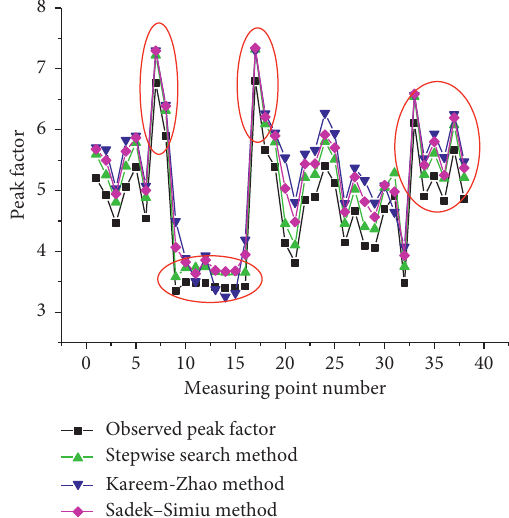
Figure 10: Comparison of peak factors at the 5 th measurement level with 90 ° wind direction